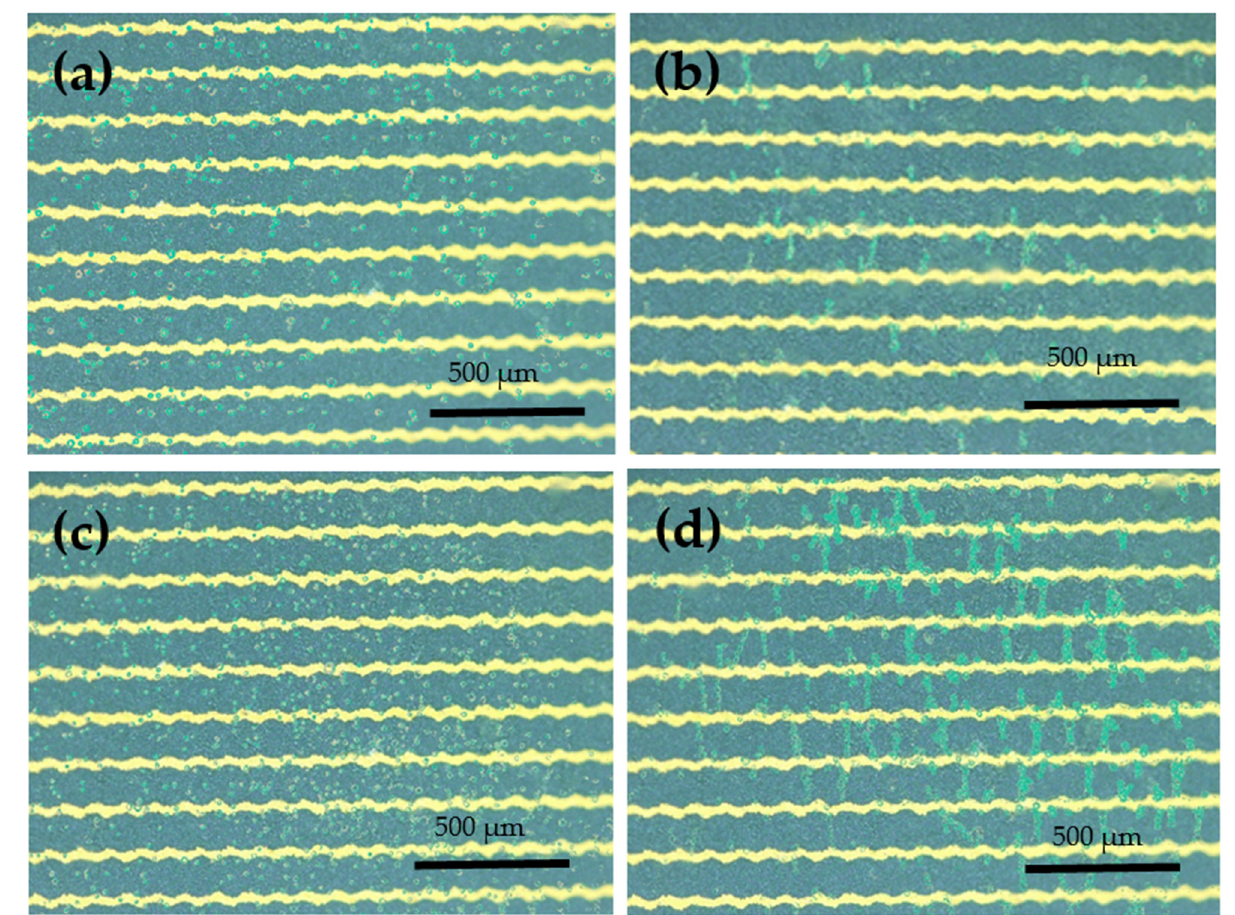
Figure 2. OM image before and after the application of 10Vp-p AC voltage to the biosensor chip. ( a ) and ( b ) Images of 6000 CE81T cells before and after the application of DEP, respectively. ( c , d ) Images of 30,000 CE81T cells before and after the application of DEP, respectively.